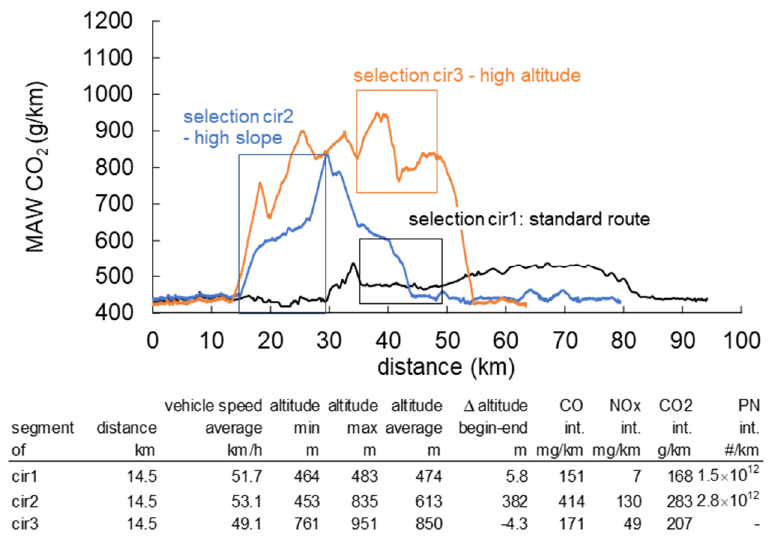
Figure 13. Selection of characteristic circuit segments for better visualization of influences of altitude and altitude variations.